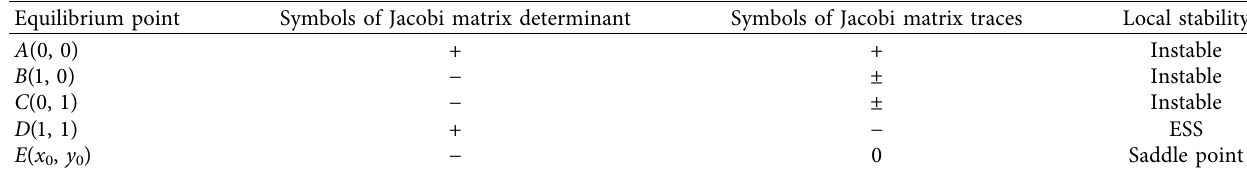
Table 5: Local stability analysis of equilibrium points.